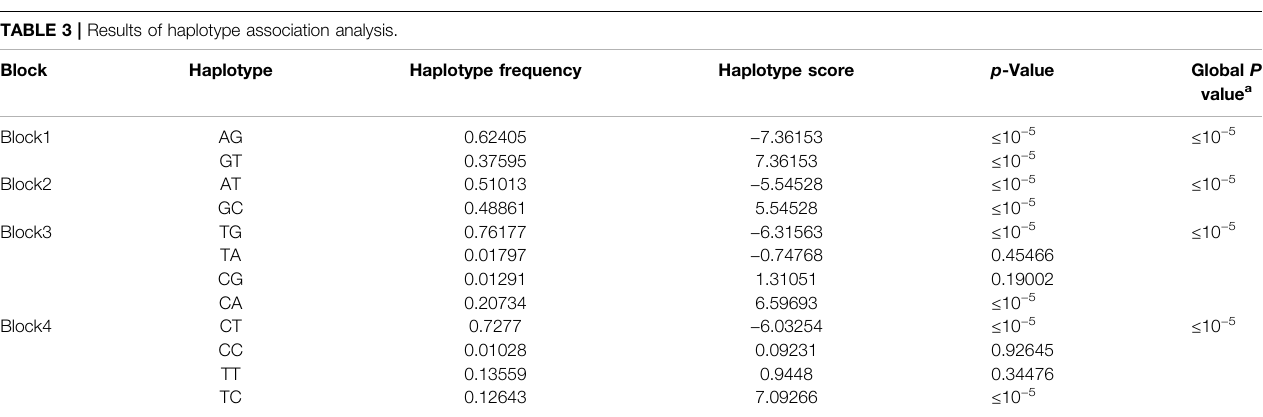
TABLE 3 | Results of haplotype association